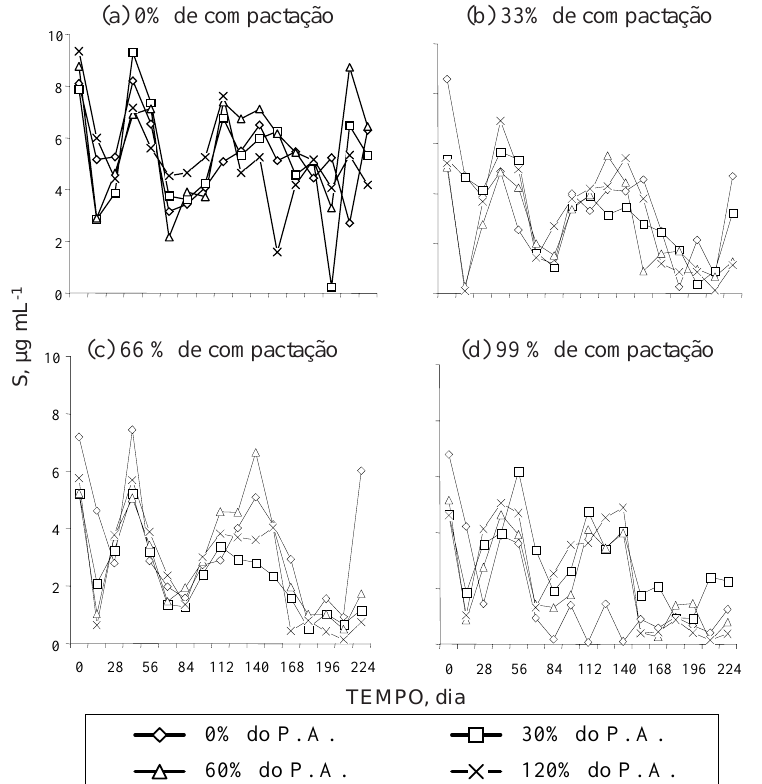
Figura 3. Teores de sulfato nos lixiviados, considerando o tempo, para diferentes doses de carbonato e níveis de compactação.